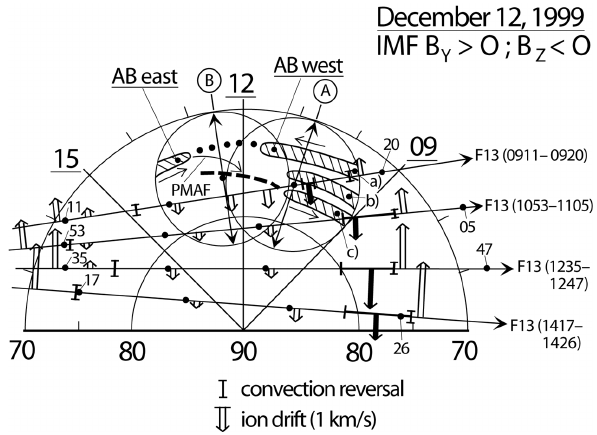
Fig. 15. Schematic illustration of the dayside auroral configu- ration in the 09:00–14:00 MLT sector, applicable to the interval 07:00–10:00 UT on 12 December 1999, and polar cap convection derived from four DMSP F13 passes during the interval 09:10– 14:30 UT. The coordinate system is MLAT/MLT. The fields of view at 630.0nm of the MSP and all-sky camera (ASC) in Ny ˚Alesund for 07:20 UT (A) , and 09:15 UT (B) , are marked by double-arrowed meridional lines and circle, respectively. Track of DMSP spacecraft F13 during the intervals 09:11–09:20, 10:53–11:05, 12:35–12:47, and 14:17–14:26 UT are indicated. Horizontal cross-track ion drifts are marked along the tracks. Hatched areas represent the location of auroral forms. Midday gap aurora is indicated by dotted line.